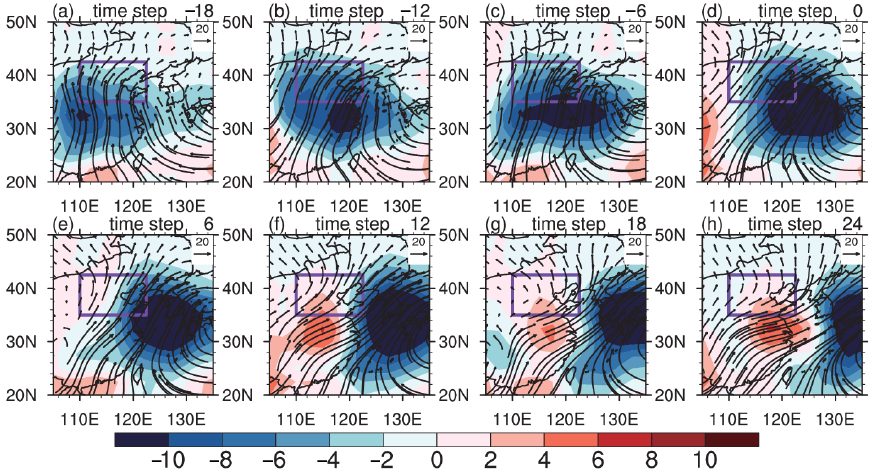
Figure 4. Evolution of vertically integrated WVT anomalies (vectors, kg/(m·s) with respect to winter climatology and the associated divergence (colors, 10 –5 kg/(m 2 ·s)) at time steps (a) –18, (b) –12, (c) –6, (d) 0, (e) 6, (f) 12, (g) 18, and (h) 24 for ISEs in NC.